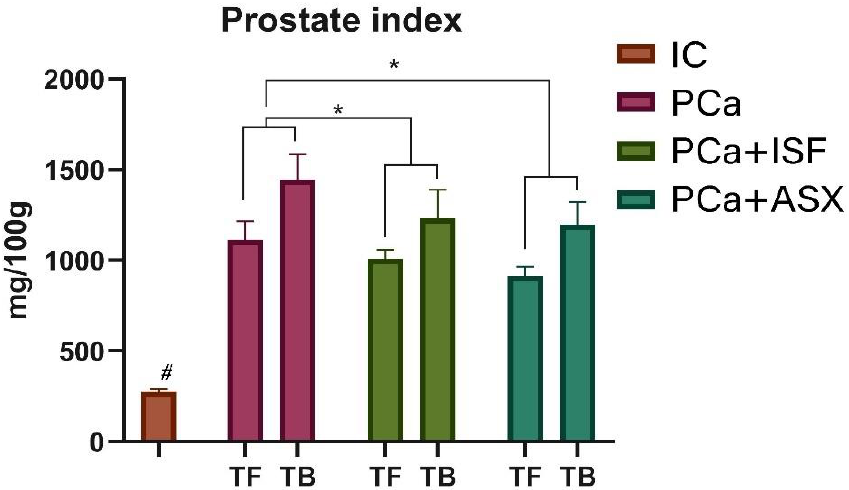
Figure 2. Prostatic index in tumor-free and tumor-bearing animals. IC—intact control. PCa—prostate